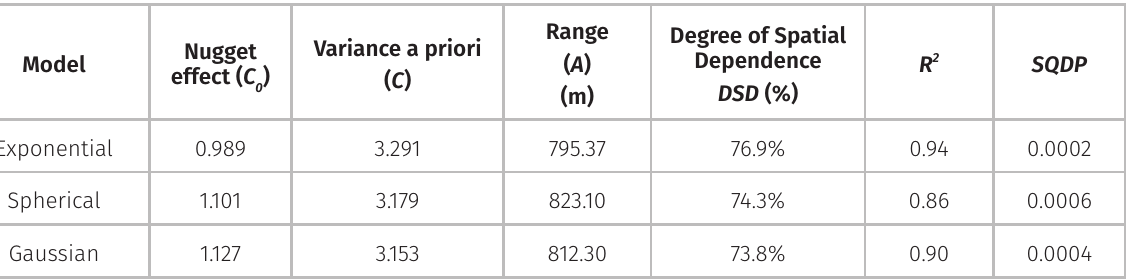
Table IV. Results of the semivariograms adjusted for h region of